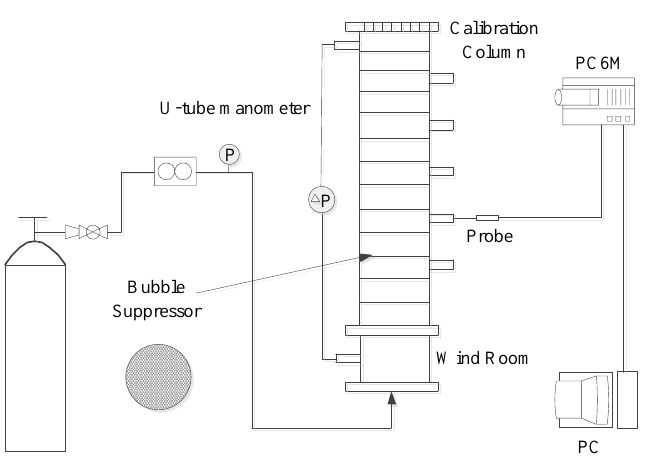
Figure 4. Calibration apparatus.